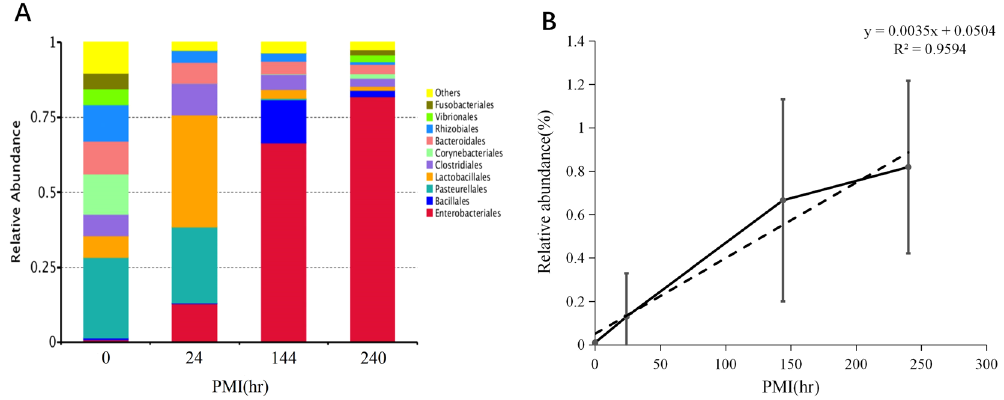
Figure 4. ( A ) Relative abundance of orders of bacteria with different PMI. ( B ) Relative abundance changes of Enterobacteriales had high positive linear relationship with PMI.